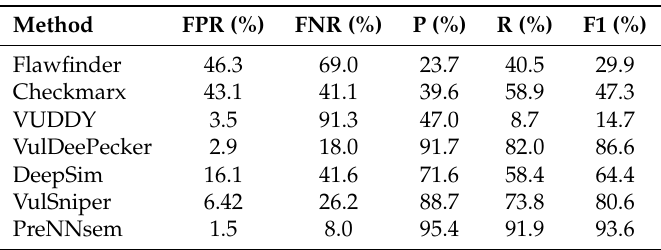
Table 7. Comparison of experimental results obtained using the proposed method and those using state-of-the-art